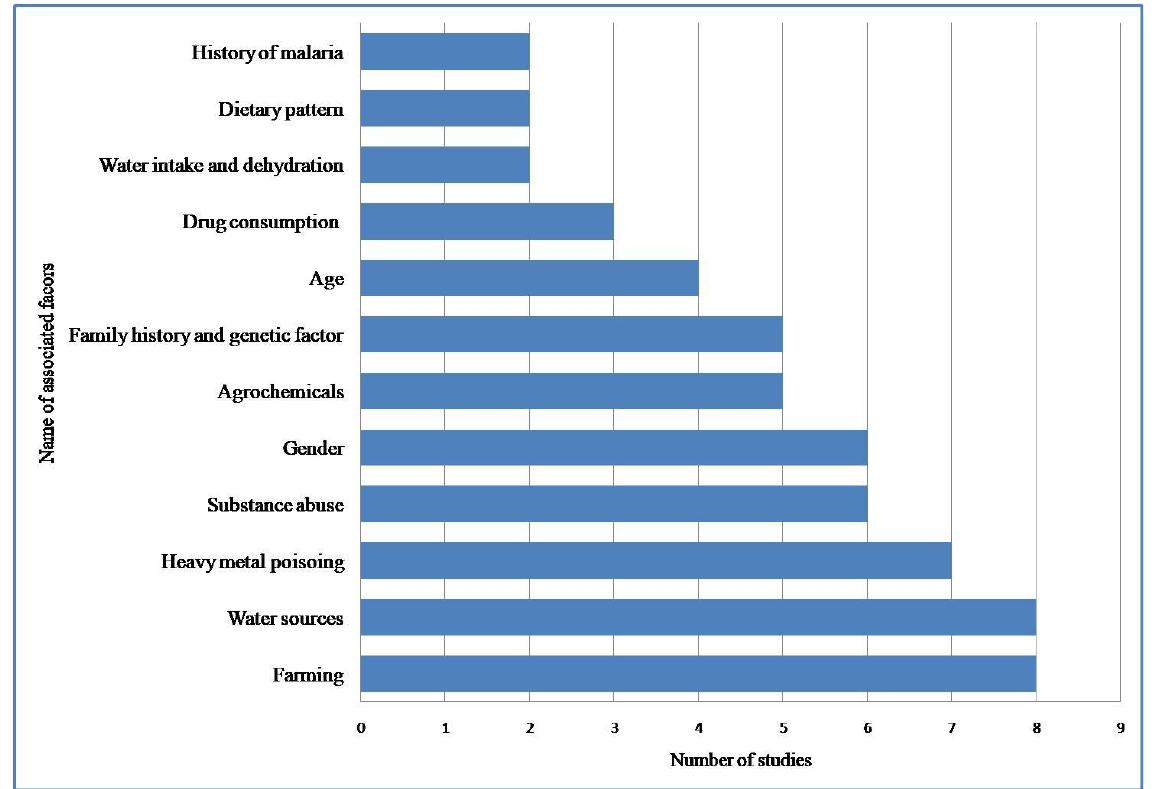
Figure 2. Number of included studies reporting associated factors.